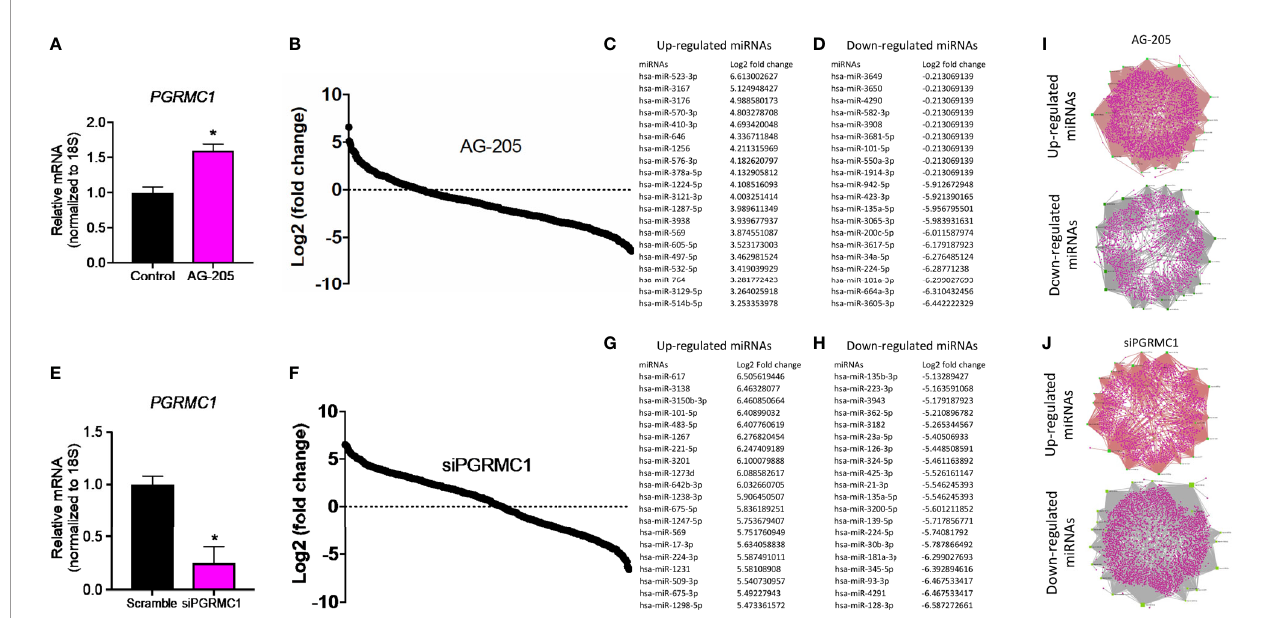
FIGURE 1 | Human miRNome pro fi ling identi fi ed differentially regulated miRNAs following PGRMC1 signal disruption and silencing. (A) Relative mRNA expression of PGRMC1 in MDA-MB-468 breast cancer cells following 50 µM AG-205 after 24 h. (B) Whole human miRNome pro fi ling identi fi ed differentially expressed miRNAs following signaling disruption by AG-205 treatment. (C) The top 20 most upregulated miRNAs were identi fi ed all which had a log2 (fold change) greater than 3. (D) The 20 most downregulated miRNAs, all which had a log2 (fold change) less than 1. (E) Relative mRNA expression of PGRMC1 in MDA-MB-468 cells following PGRMC1 silencing after 48 h. (F) miRNome pro fi ling identi fi ed differentially expressed miRNAs following PGRMC1 silencing. (G) The 20 most upregulated miRNAs with a log2 (fold change) greater than 5. (H) The 20 most downregulated miRNAs were identi fi ed all which had a log2 (fold change) less than -5. (I) Interaction network hubs of the top 20 up and downregulated miRNAs and their mRNA target genes following AG-205 treatment. (J) Interaction network hubs of the top 20 up and downregulated miRNAs and their mRNA target genes following PGRMC1 silencing. Four individual networks are demonstrated with miRNAs illustrated in green, miRNA-mRNA interacting nodes in brown and target genes represented in pink. *P <